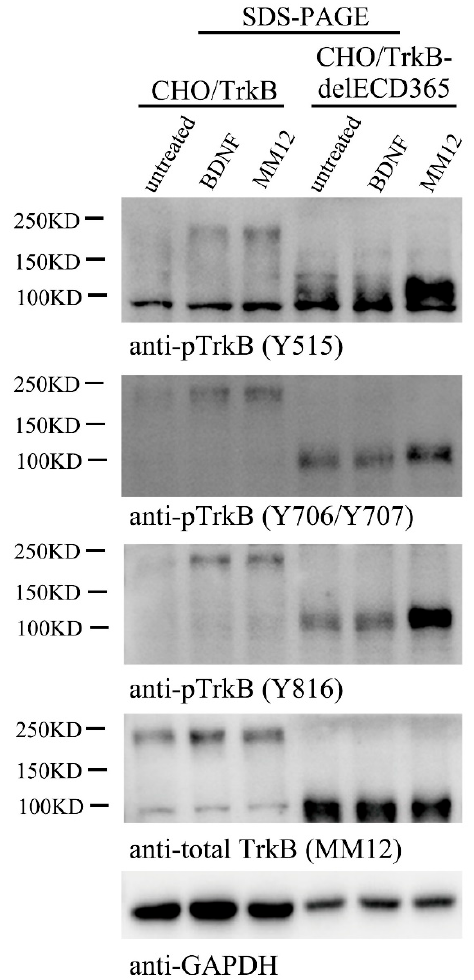
Figure 4. TrkBECD has no auto-inhibitory effect on TrkB activation. Stable CHO cells expressing full length TrkB (CHO / TrkB) or TrkB lacking ECD (CHO / TrkBdelECD365) were treated with